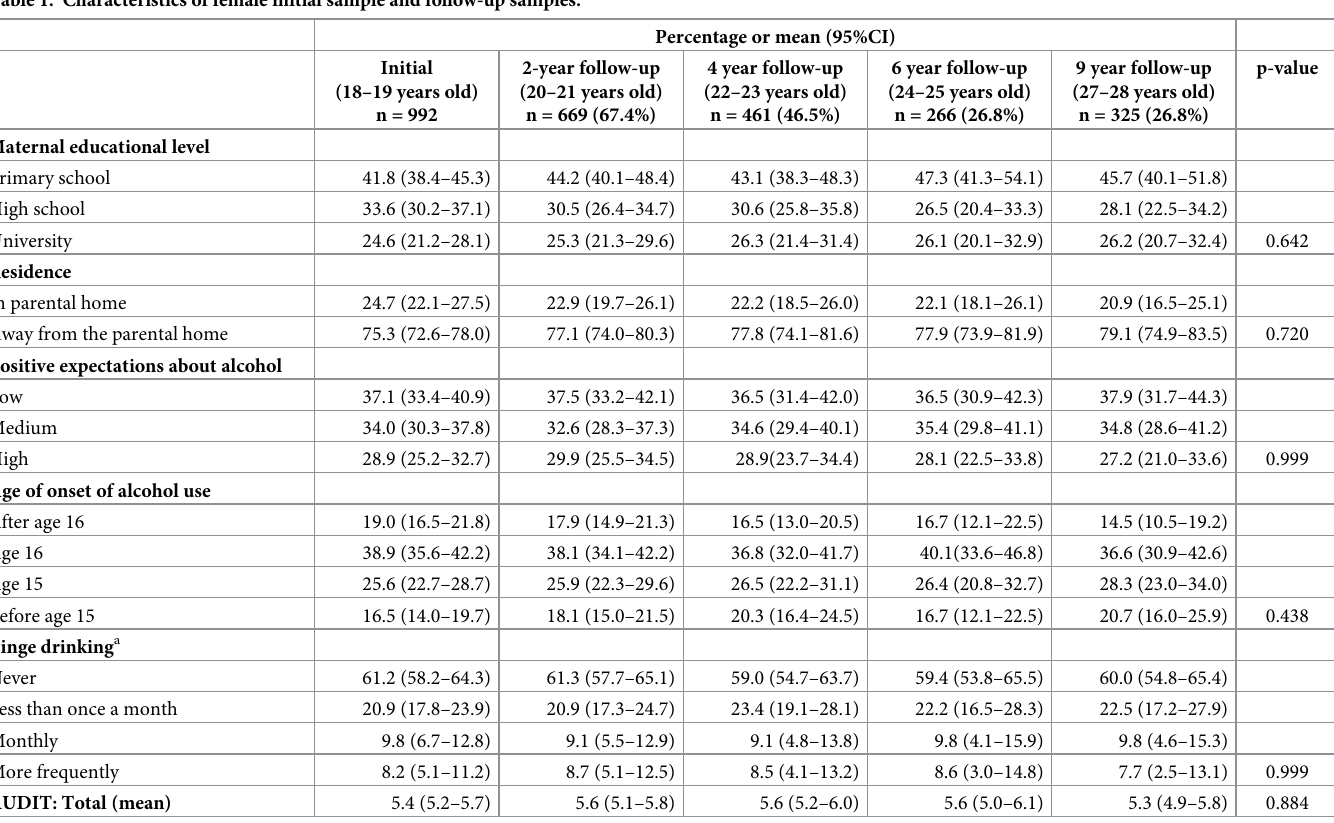
Table 1. Characteristics of female initial sample and follow-up